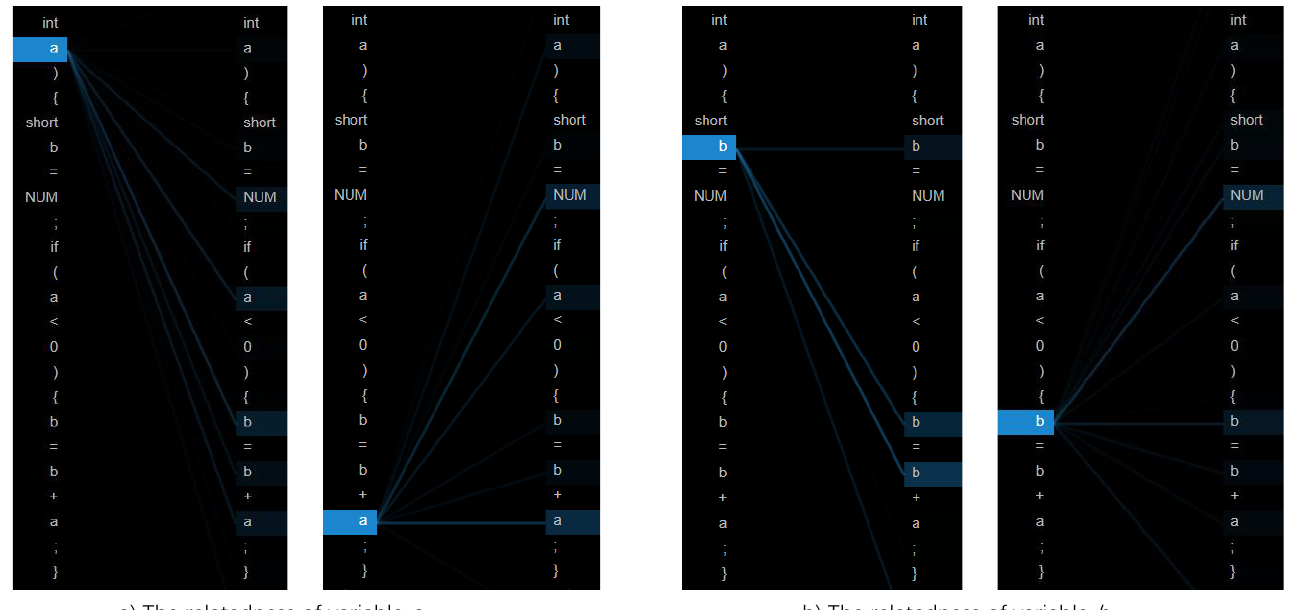
Figure 2. It presents the neuron views from four attention-heads of the second last layer of the distilled CodeBERT when the code sequence of toy examples shown in Figure 1a. It shows the captured long-range relatedness of variables a and b with other code tokens. The variables on the left are the target variables. Variables on the right which are connected by the lines from the target variable are the related variables attended by the attention-heads, showing that the model can correctly identify the variables that have relatedness. For example, Figure 2a shows that target variable a being highlighted is connected to a , and b by light blue lines, indicating that a is related to itself in a conditional expression and to b in an assignment statement of b = b + a; . In addition, variable a is also related to value NUM because NUM is assigned to variable b . This figure is generated using BertViz [49], which is a tool for visualizing attention mechanism in Transformer-based